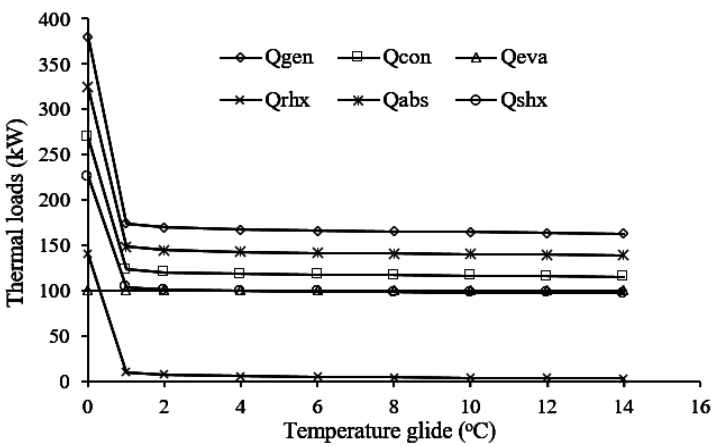
Figure 23. Effect of temperature glide on COP and ECOP.